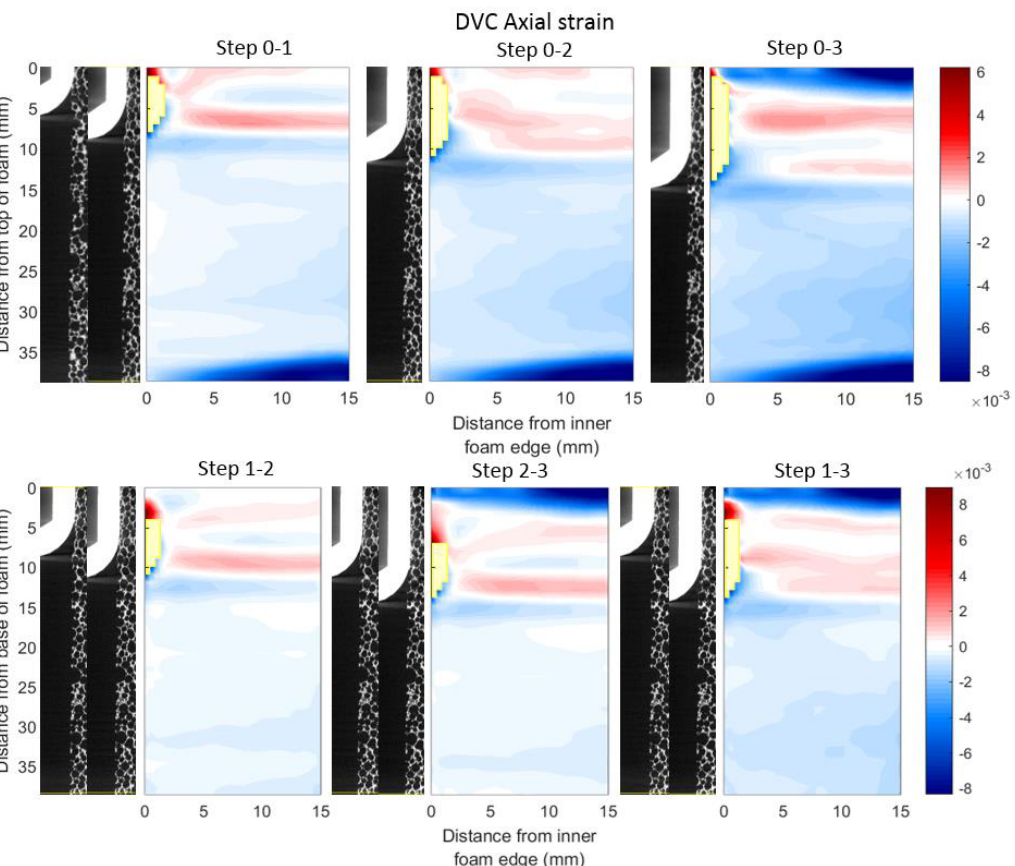
Figure 9. Axial strain fields (averaged circumferentially) for each displacement step relative to reference scan and sequential scans. Like Figures 7 and 8, the top row shows the mean strain measured relative to the reference scan and the bottom displays sequential strains. Measurements with correlation coefficients below 0.9 have been excluded and their spatial locations are shown in yellow.